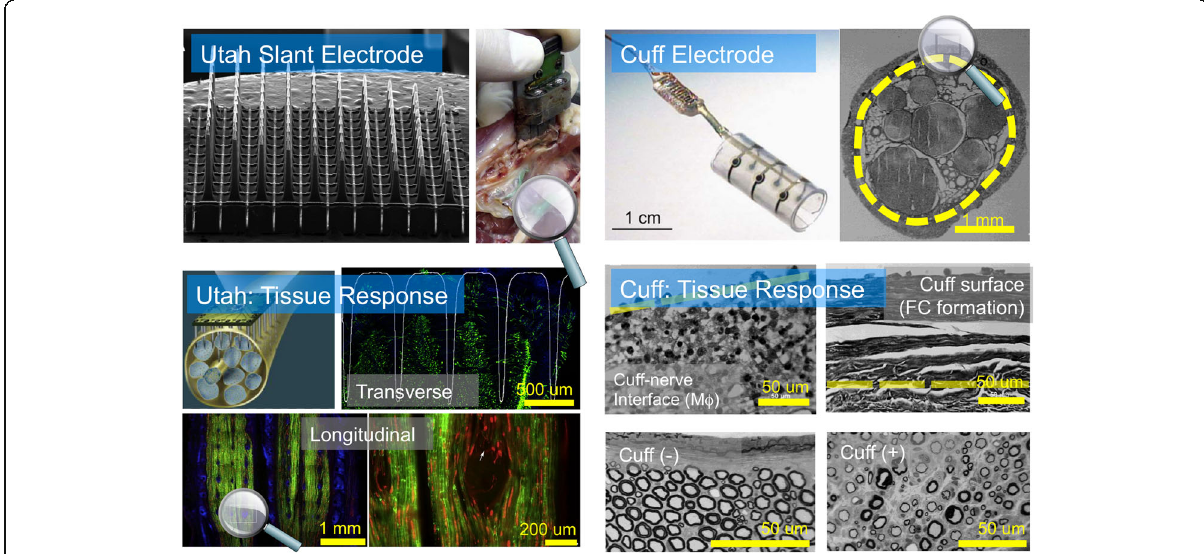
Fig. 1 Peripheral nerve interfaces (PNI) consisting of both inserted probes and cuff electrodes damage the target tissue and alter the underlying physiology. Utah slant electrodes (left) inserted into feline sciatic nerves induces inflammation, glial scarring, and rearrangement of the fascicles as shown by histology. Retraction of nerve fibers (green) is shown in the transverse axis while rearrangement of the fibers is shown in the longitudinal axis. This figure is adapted from the following sources and used with permission: Grill et al. (copyright 2000 John Wiley & Sons) (Grill & Mortimer, 2000); Christensen et al. (copyright 2014, Springer) (Christensen et al.,